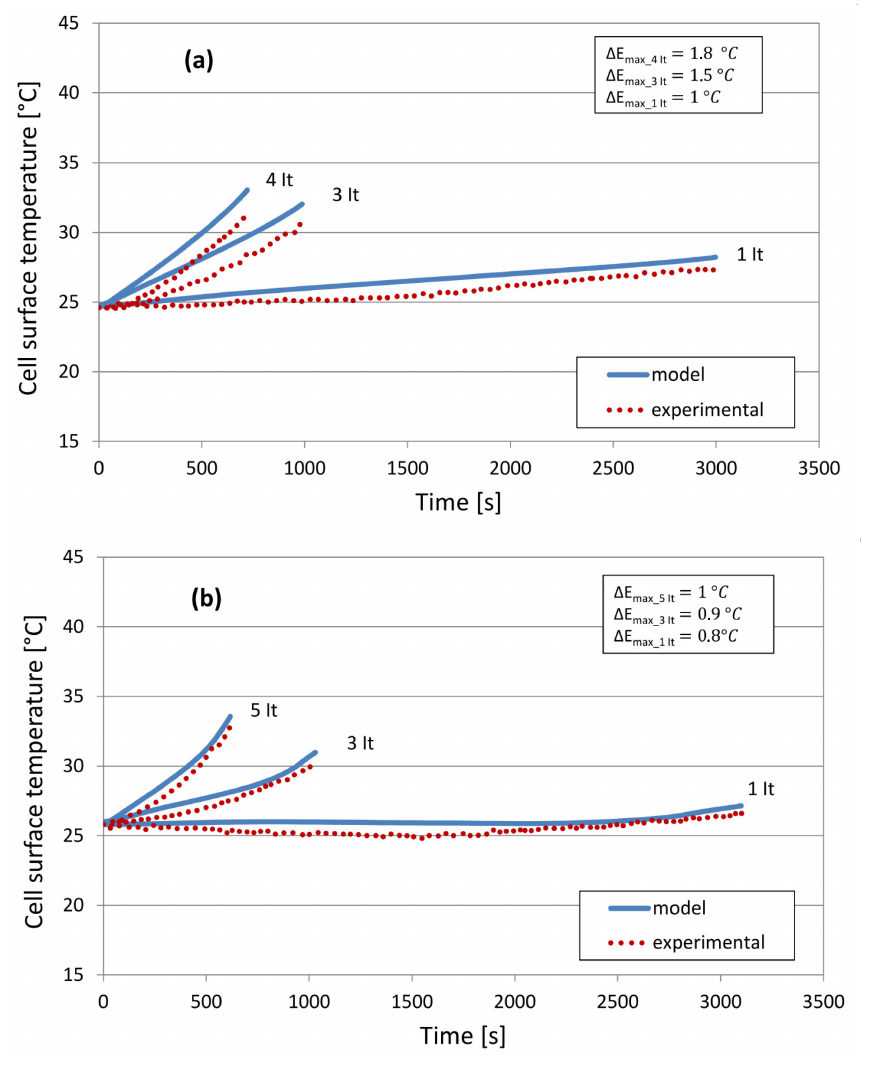
Figure 8. Surface temperature evolution of the cell with a discrete internal region for constant: ( a ) charge and ( b )